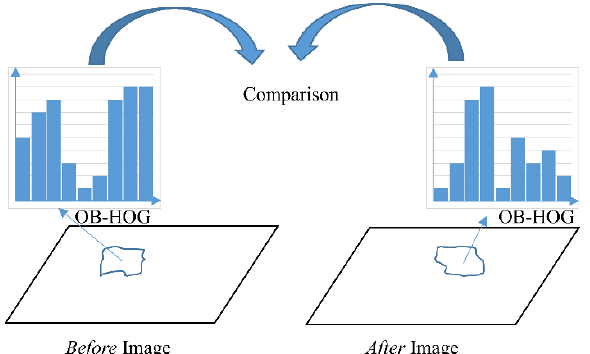
Figure 3: The process of using Object-Based HOG feature descriptor for damage detection. The HOG feature descriptor is generated over corresponding segments and then compared in order to detect changes.